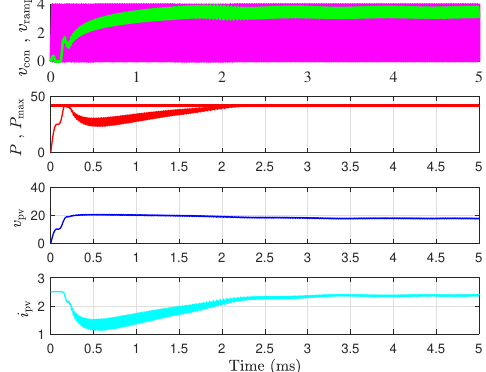
Figure 8. The startup response of the quadratic boost converter with a nonlinear PV source under MPPT control S = 500W/m 2 , V M = 4 V. Θ = 25 ◦ C.